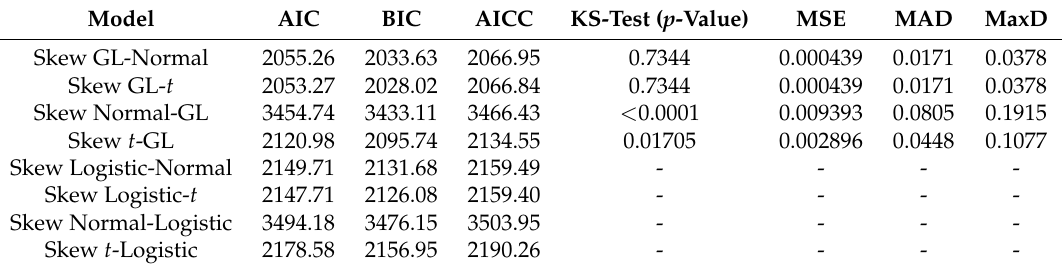
Figure 11. Faithful data - PP-Plot. ( a ) Skew Normal-GL; ( b ) Skew GL-Normal; ( c ) Skew t -GL; ( d ) Skew GL- t . Table 3. Performance and accuracy of the